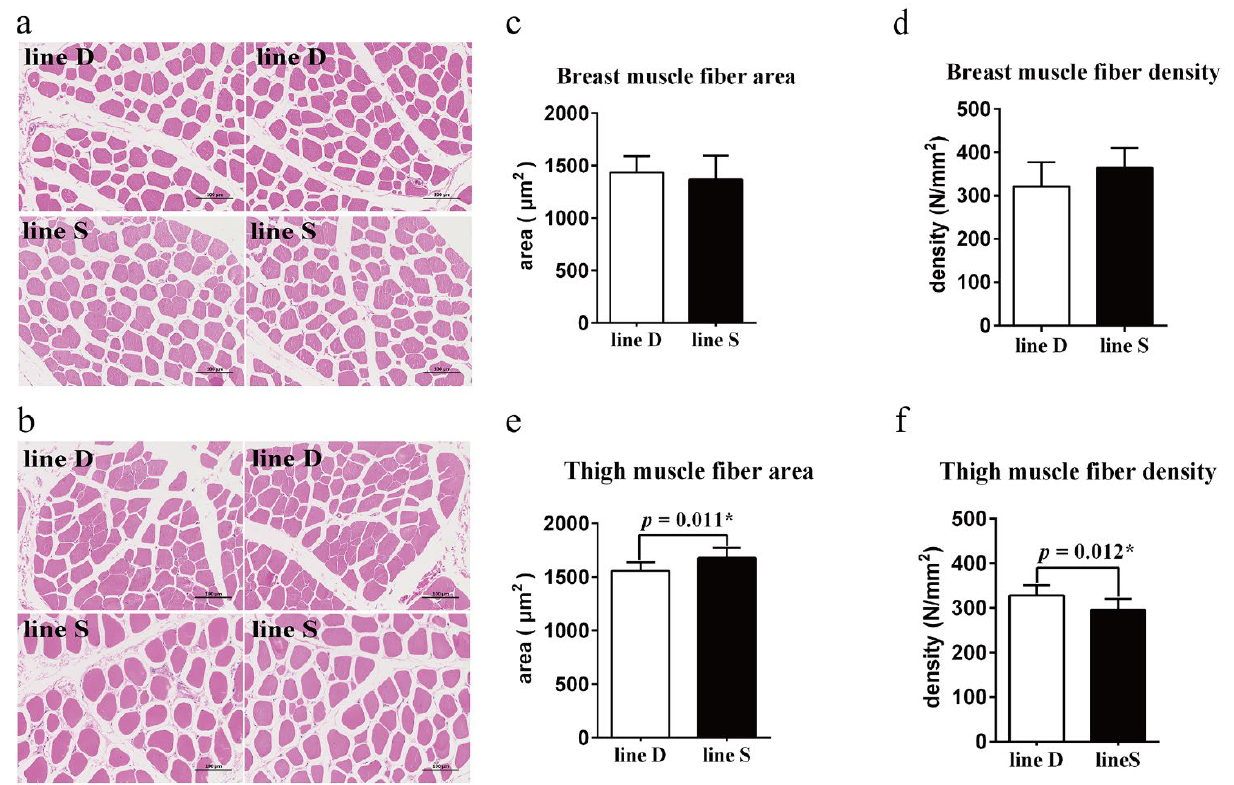
Figure 2. Comparison of muscle fiber morphology and myofiber characteristics between the two lines. Myofiber morphology observation of breast muscle ( a ) and thigh muscle ( b ) tissue section. There are two images for each chicken line of different muscle tissue. Scale bar, 100 µ m. Muscle fiber area ( c ) and muscle fiber density ( d ) of breast muscle. Muscle fiber area ( e ) and muscle fiber density ( f ) of thigh muscle. Values are shown as mean ± SD ( n = 3 per group). * represents p <